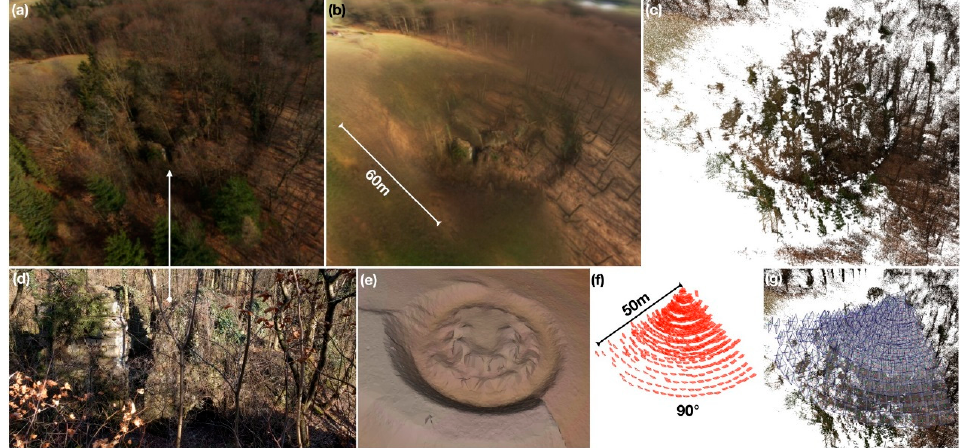
Figure 4. Ruins of an early 19th century fortification tower near Linz, Austria, as seen from the air ( a ). The structure of the remaining inner and outer ring walls and a trench become visible after optical sectioning ( b ). Image preprocessing (rectification and pose estimation) for AOS took 23 min. Photometric 3D reconstruction took 15 h (without tree removal) and does not capture the site structures well ( c ). Remains of the site as seen from the ground ( d ). An LiDAR scan with a resolution of 8 samples/m 2 ( e ) does not deliver surface color but provides consistent depth. The synthetic aperture for AOS in this experiment was a 90 ◦ sector of a circle with 50 m radius and was sampled with 505 images at an altitude of 35 m above the ground ( f , g ). For our camera drone, this leads to effectively 74 samples/m 2 on the ground. 3D visualization results are shown in Supplementary Materials Video